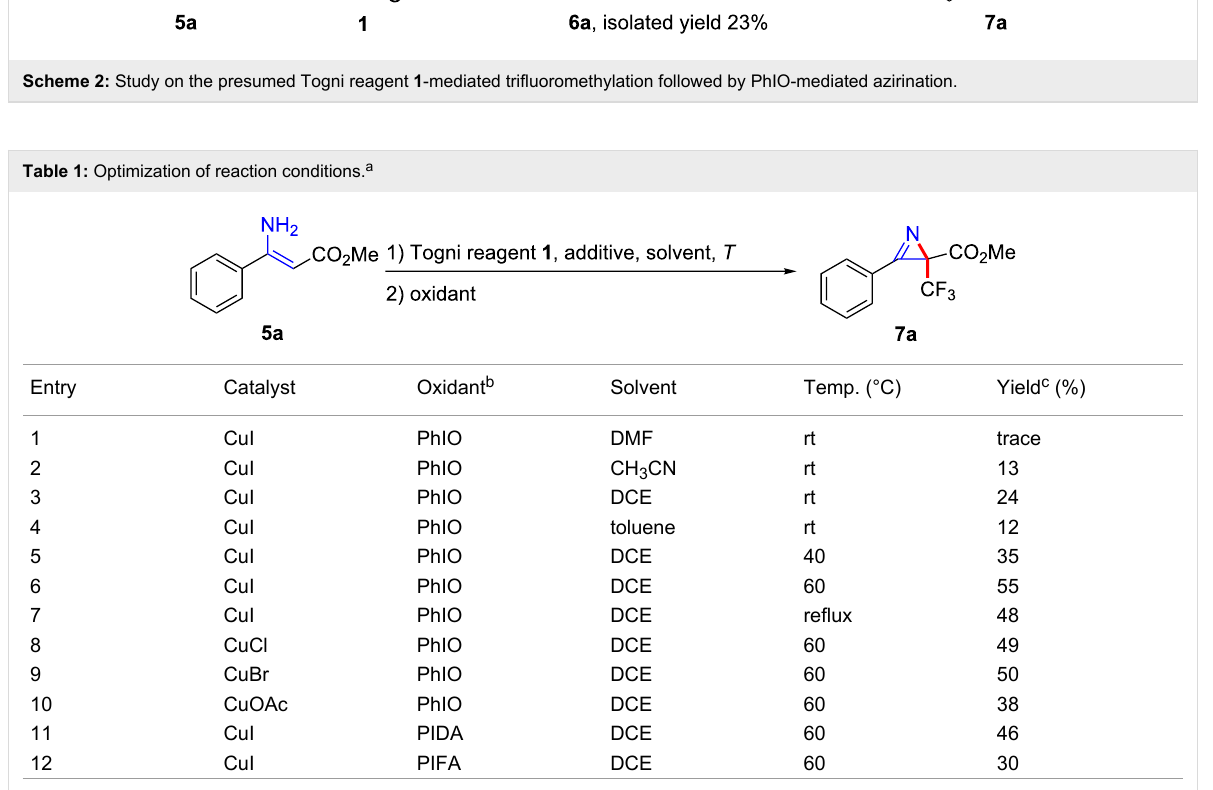
a Reaction conditions: Togni reagent 1 (1.2 mmol), 5a (1.0 mmol), catalyst (0.2 mmol), oxidant (1.5 mmol) in solvent (10 mL) unless otherwise stated. b The oxidant was added to the reaction mixture after the substrate 5a was completely consumed (TLC analysis). c Isolated